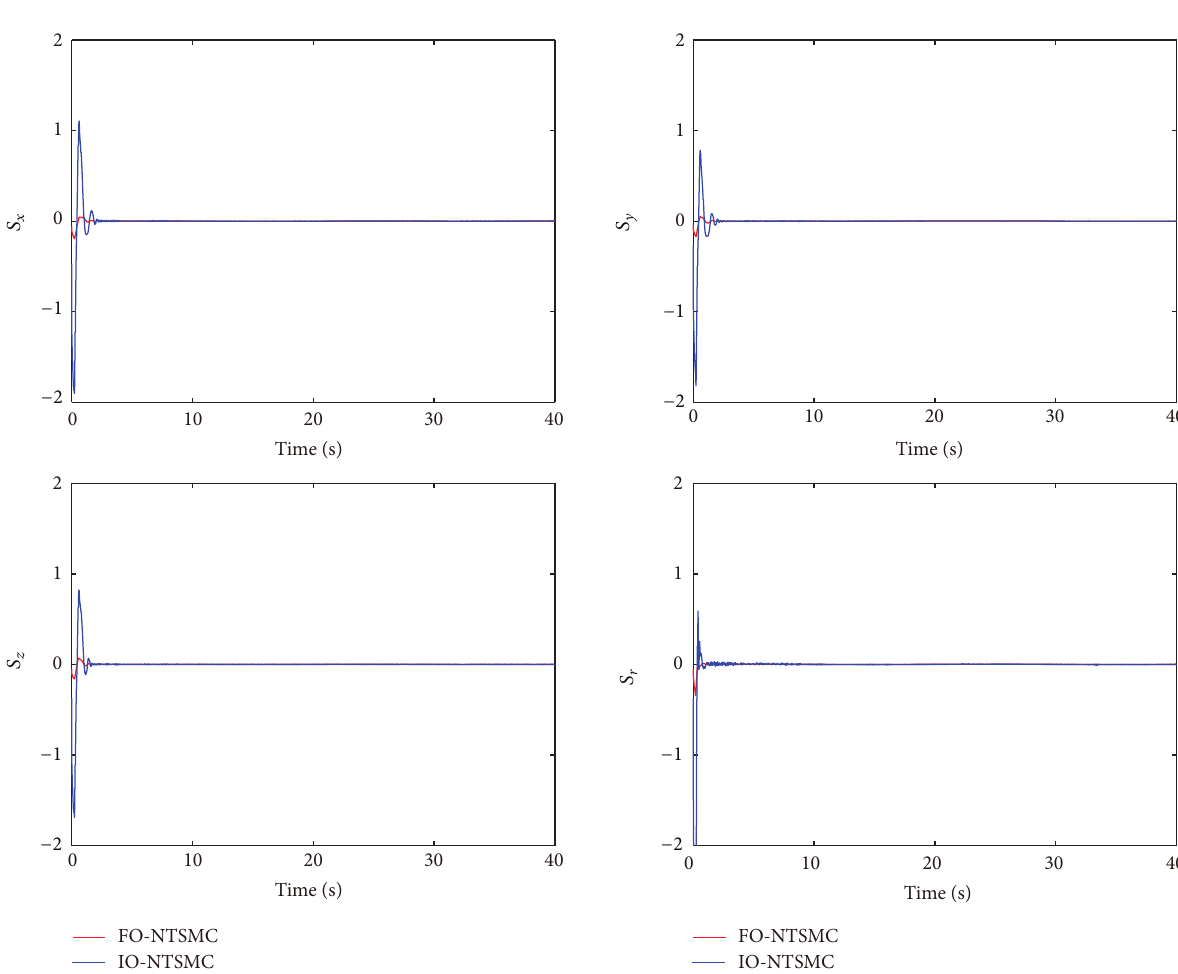
Figure 15: Sliding manifold of output feedback FO-NTSMC and IO-NTSMC with boundary